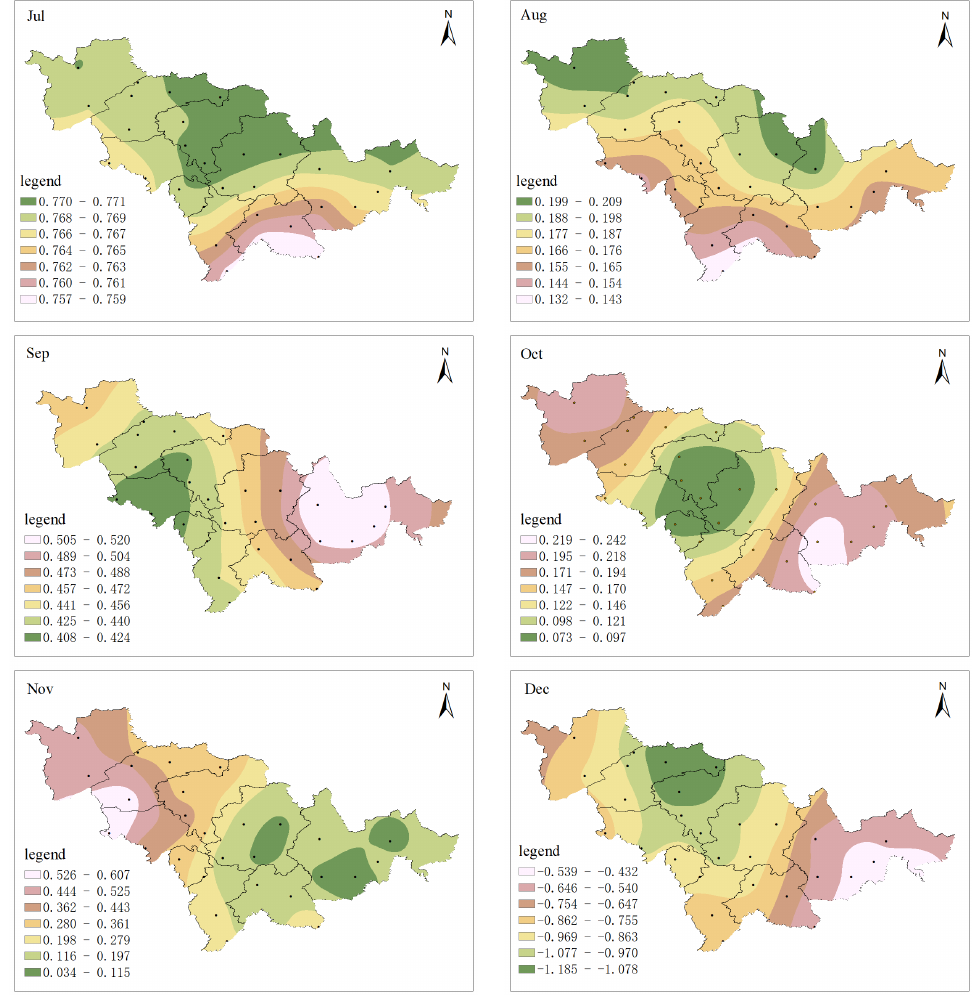
Figure 5. Spatial variation of monthly average temperature difference between 2010–2019 and 1980–2009 in Jilin Province, China (the unit of legend is